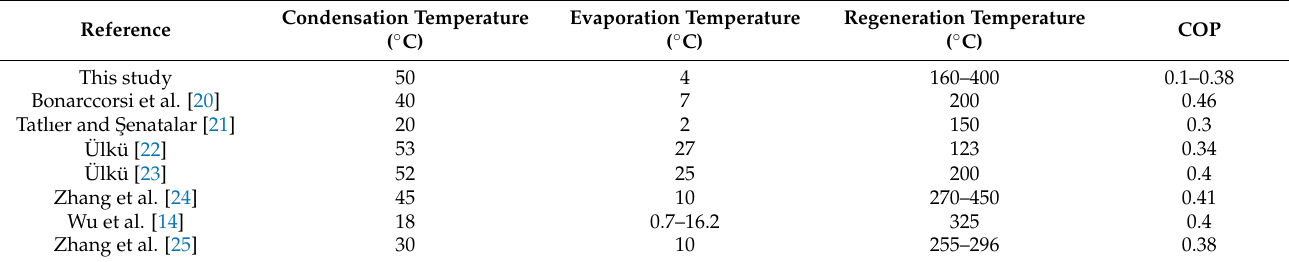
Figure 8. Refrigeration and heat pump coefficient of performance (COP) relative to exhaust tem- Table 4. Coefficient of performance (COP) values researched in the perature.